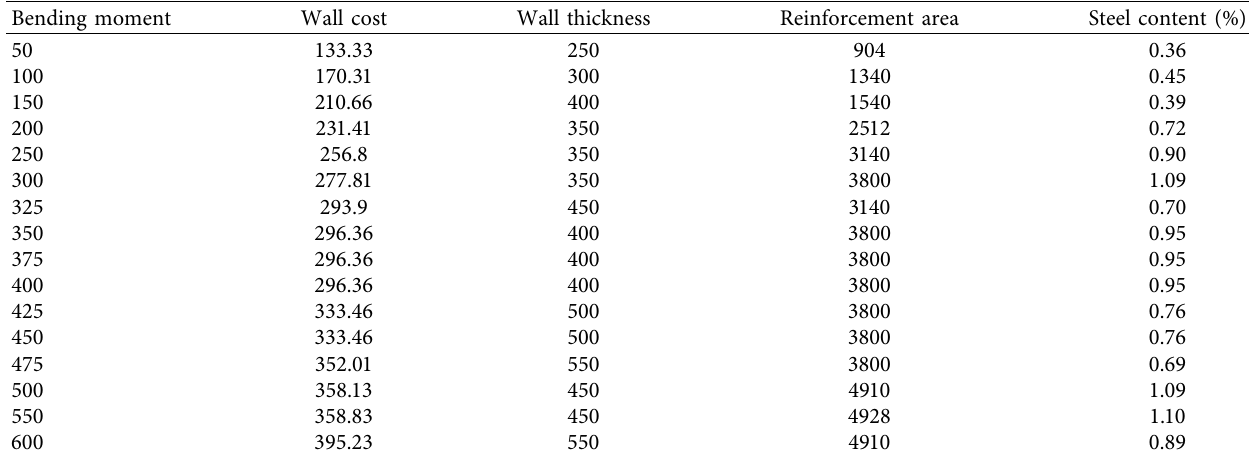
Table 8: Minimum wall costs per unit area (yuan) and the optimal steel contents.